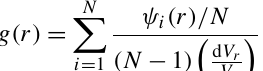
Figure 1. A two-dimensional cartoon of the different ways of tra- ditionally dealing with domain edges when computing the radial distribution function. Panel (a) shows approaches related to a peri- odic boundary condition approach, whereas (b) illustrates a guard area